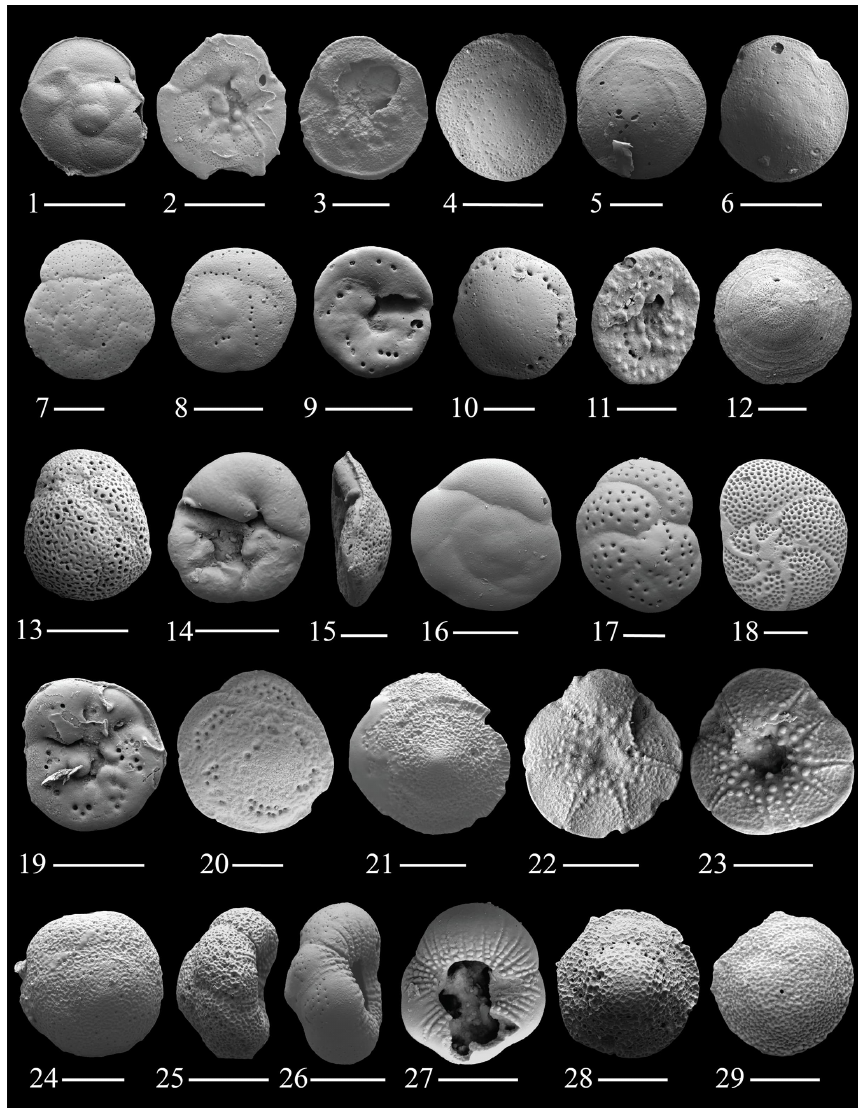
Figure 7. (1–3) Orbitina carinata Sellier de Civrieux; (4–6) Rotorbis auberii (d’Orbigny); (7–9) Neoconorbina sp. 1; (10–11) Neoconorbina radiatogranulata Parker; (12) Neoconorbina terquemi (Rzehak); (13–15) Rosalina bradyi (Cushman); (16) Rosalina sp. 1; (17–19) Ros- alina sp. 2; (20–23) Glabratella carinata Seiglie and Bermúdez; (24–27) Glabratella mirabilis Seiglie and Bermúdez; (28–29) Glabratella carinata Seiglie and Bermúdez. The scale bar is 100 and 50µm for figs. (3) – (5) , (7) , (10) – (12) , (14) – (15) , (17) , and (20) – (29) .